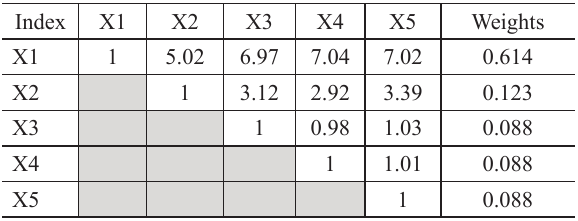
Table 3. Importance degree of assessment indexes and selection of different resistant glass facades against